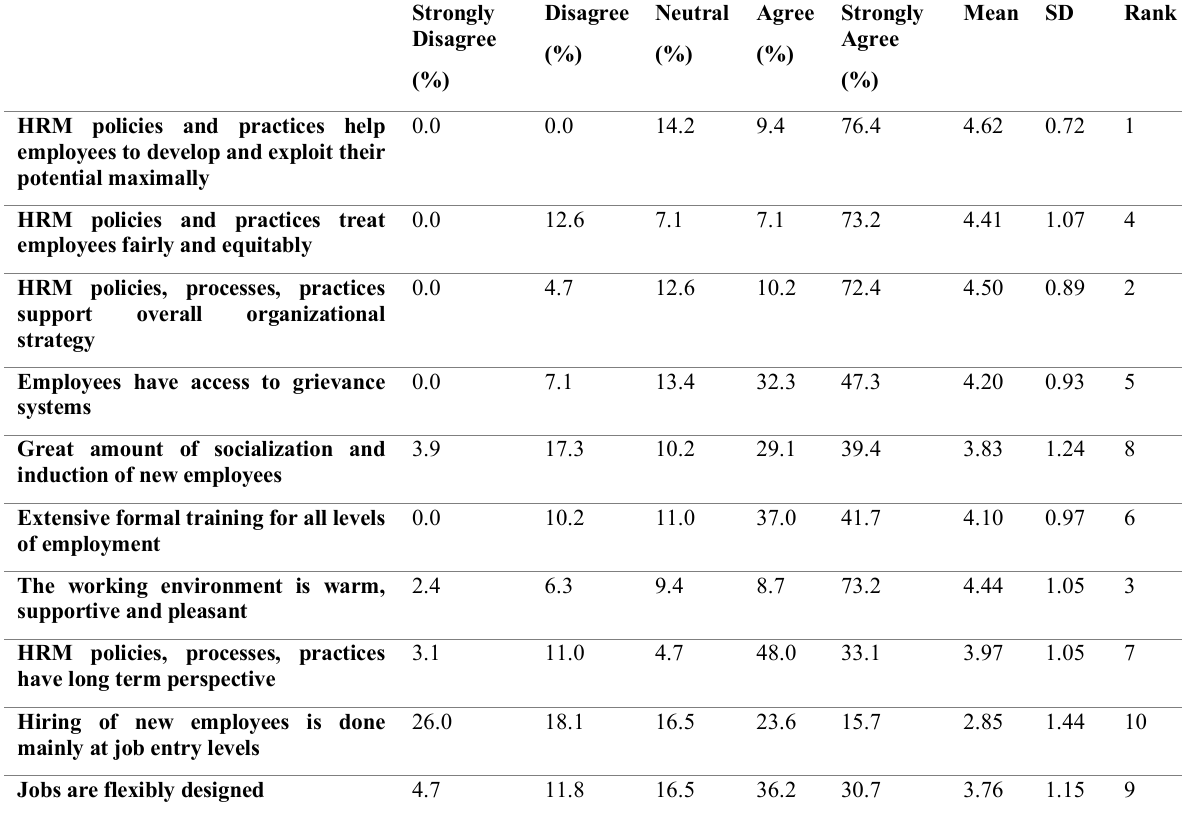
Table 1: Descriptive statistics for human resource